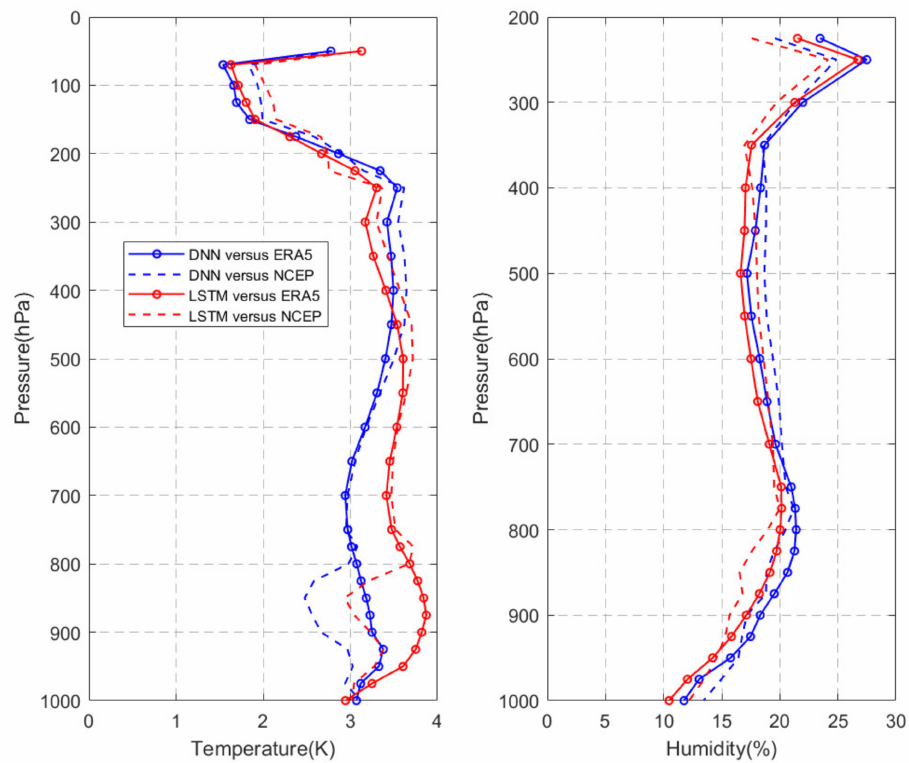
Figure A8. The retrieval RMSEs of the DNN model and the LSTM model with respect to ERA5 and NCEP reanalysis data over mixed surface in September